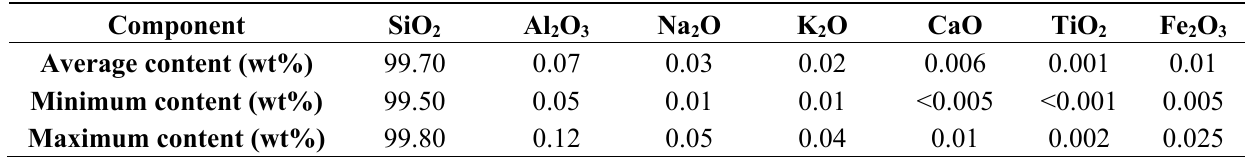
Table 2. Chemical composition of sand particles.